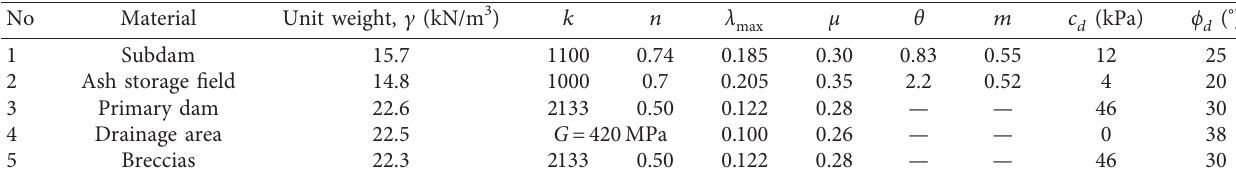
Table 4: Model parameters for dynamic